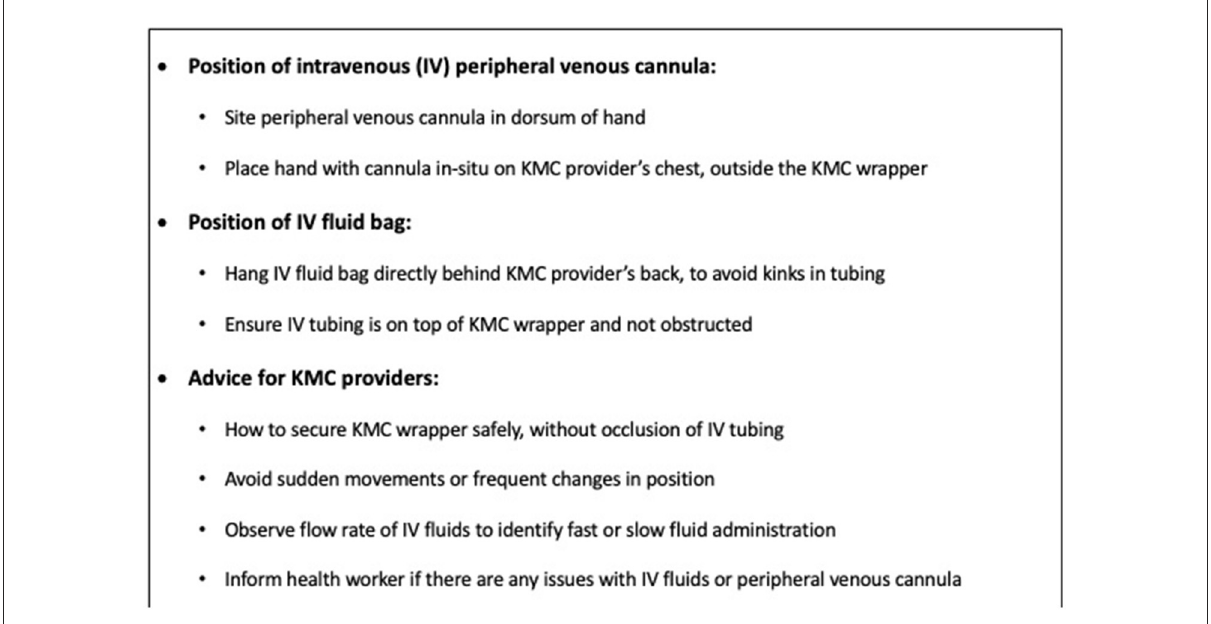
FIGURE2 Recommendations to enhance safety of intravenous fluid administration whilst in KMC